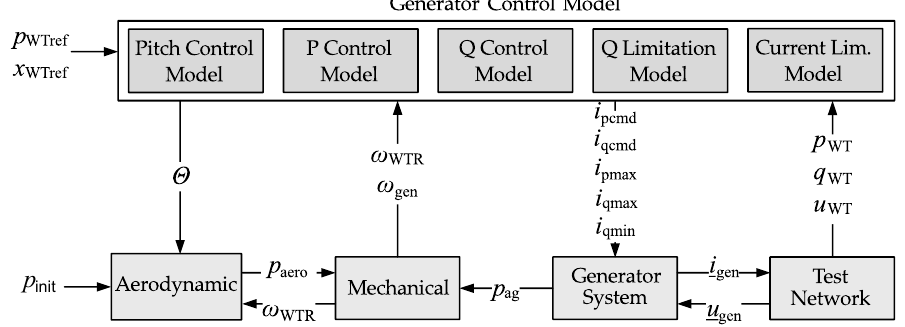
Figure 4. Modular structure of the IEC generic Type 3B WT model adapted from